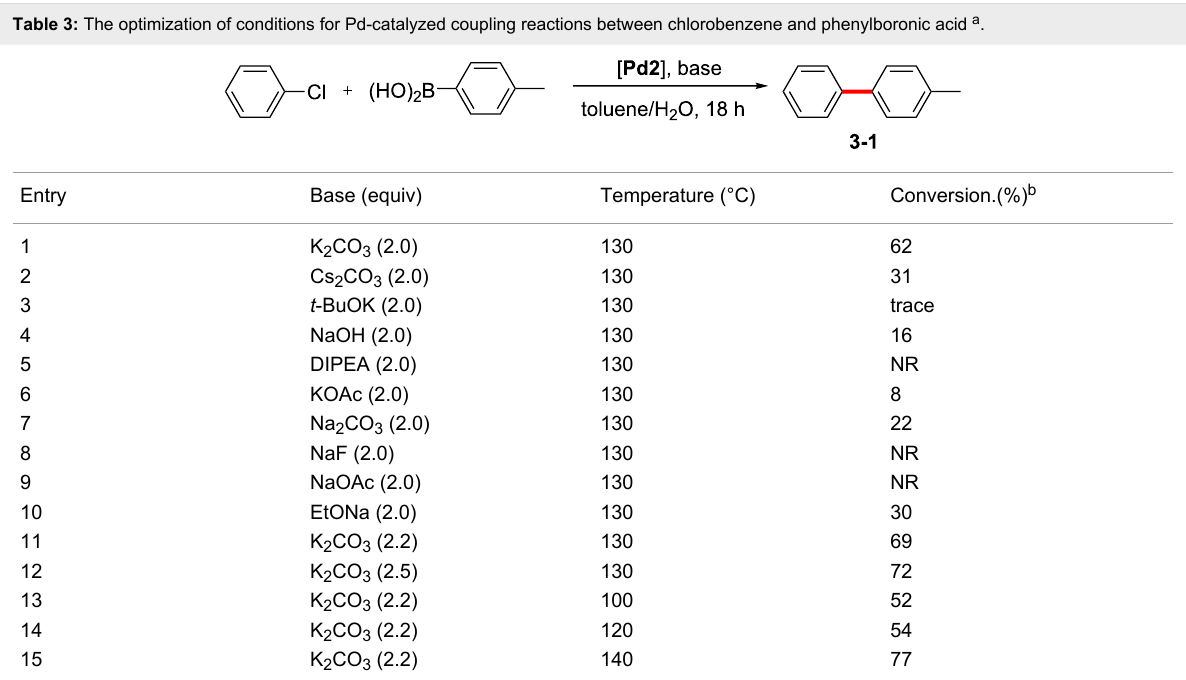
Table 3: The optimization of conditions for Pd-catalyzed coupling reactions between chlorobenzene and phenylboronic acid a .